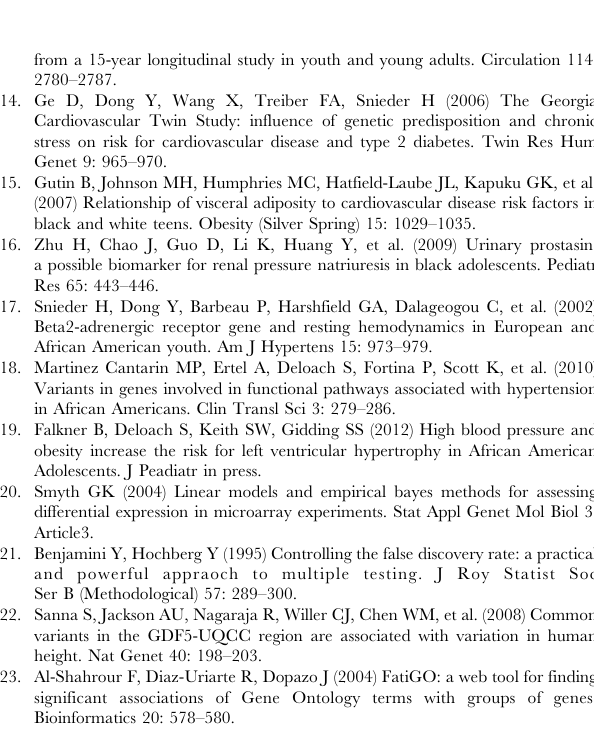
Table S1 General characteristics of the MZ pair discordant for EH. Table S2 Replication results for PRCP gene. Table S3 Correlation among the CpG sites in the SULF1 gene. Table S4 Correlation among the CpG sites in the PRCP gene. Table S5 Gene-Ontology analysis. Table S6 Cell population estimates in cases vs.